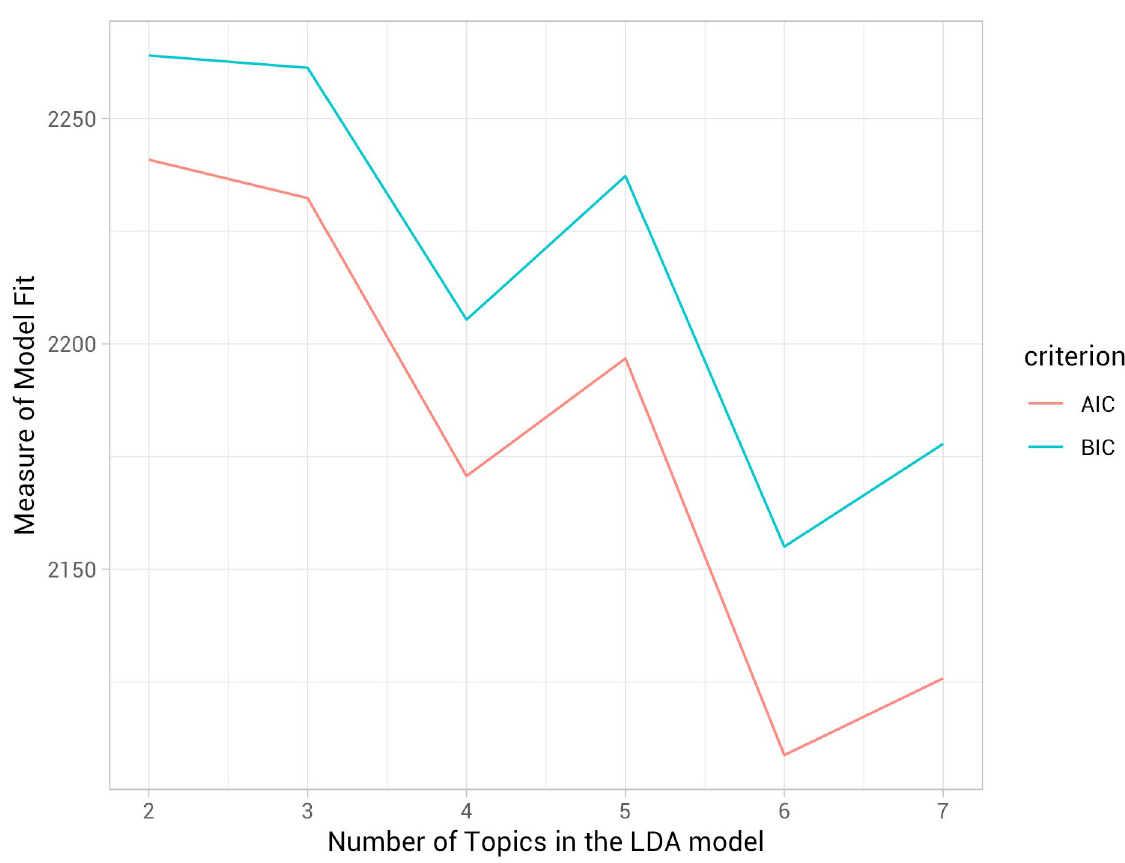
Fig 4. Comparison of model fit of LDA with different number of